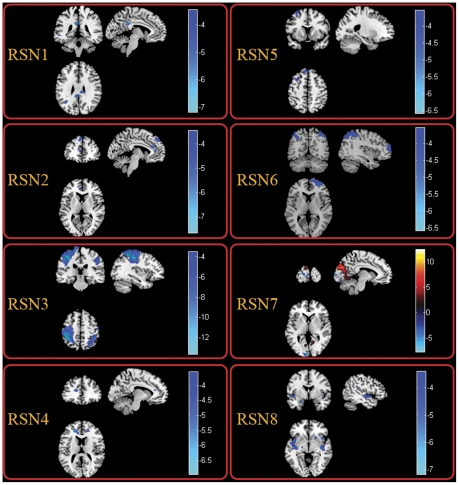
Two-sample t-tests results of the eight RSNs between TLE and HC (P<0.05 corrected by FDR).The warm and cold colors indicate the brain regions with significantly increased and decreased functional connectivity in TLE compared with HC, respectively. The left side of the image corresponds to the left side of the brain.